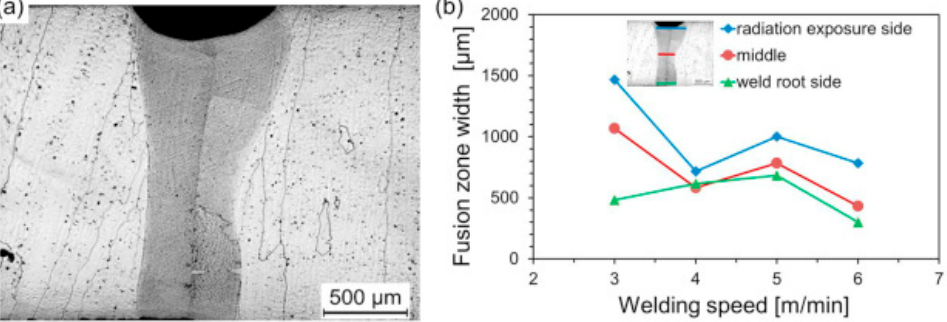
Figure 7. ( a ) Macrograph of weldment corresponding to 5 mm/min, ( b ) variation of fusion zone width with welding speed. Reproduced with permission from [73]. Copyright Elsevier, 2019.